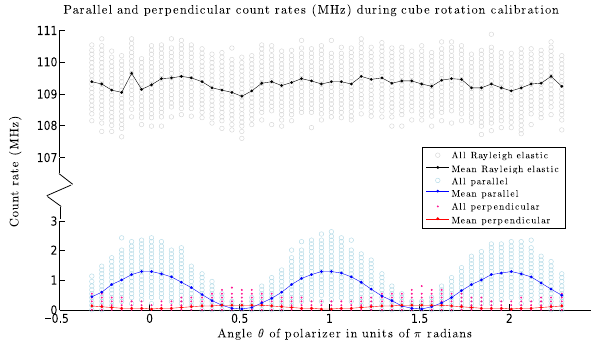
Figure A1. Polarized calibration measurements as a function of in- cident light polarization angle for all channels. Note the broken axis; the polarization-independent Rayleigh elastic measurements (grey circles and black line) are an order of magnitude larger than the par- allel (light blue circles and blue line) and perpendicular (pink points and red line)